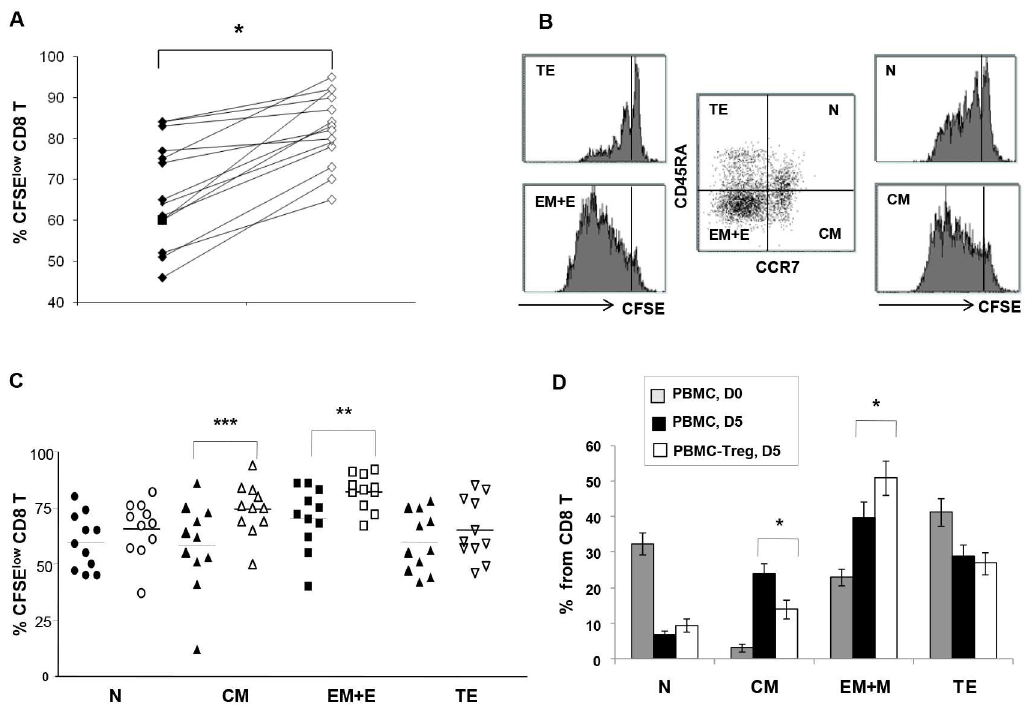
Fig 1. Treg inhibit the proliferation of CD8 T cells from HIV+ patients in a subset-specific manner. A. Individual data (n = 14) of proliferation rates of CD8 T cells after polyclonalstimulation (5d, anti-CD3) in the presence (black) or in the absence (white)of Treg. B. Representative dot-plot of CD8 T cell-gated PBMC showingthe CCR7/CD45RA defined subsets: na ï ve (N), central memory (CM), effector-memory and effector (EM+E), terminal effector (TE), at D5 of anti-CD3 stimulation, and their further analysis accordingto CFSE intensity. C . Individual data ofproliferation rates of CCR7/CD45RA-definedCD8 T (CD8 N, CM, EM+E, and TE) subsets ( ** P < 0.01, *** P < 0.001, n = 11, Student’s T- test). D . Proportions of CCR7/CD45RA-definedCD8 T subsets before (grey) and after polyclonal stimulation, in the presence (black) or in the absence (white) of Treg. Bars correspondto mean ± SD, n = 11, * P < 0.05, Student’s